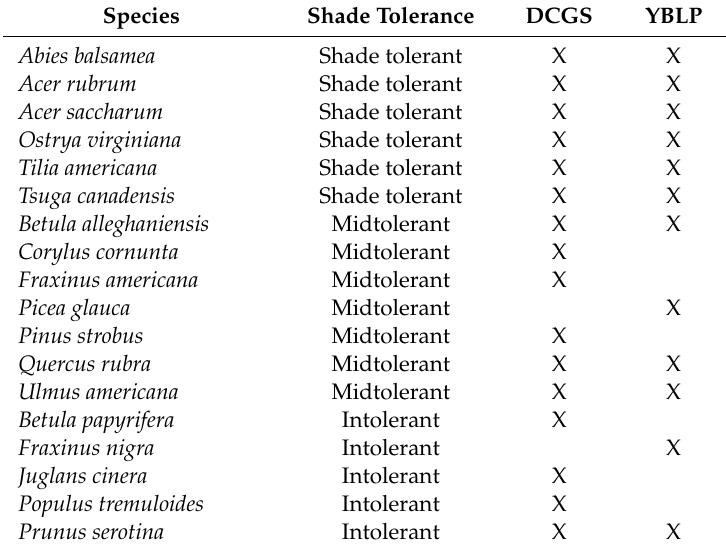
Table 1. Shade tolerance classification of primary species present at two group-selection study sites in northern hardwood forests of the upper Great Lakes, USA. Table modified from Burns and Honkala [58]. Species marked with ‘X’ were found in each respective study